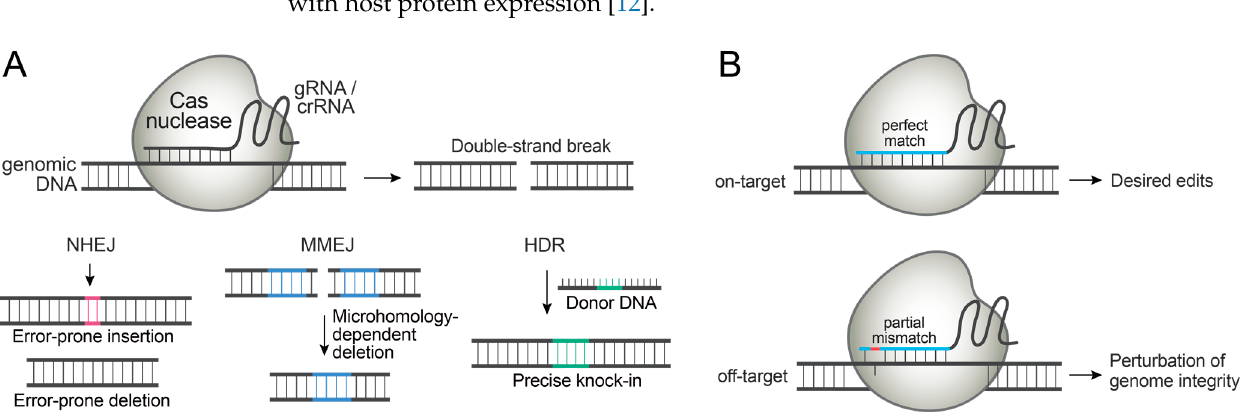
Figure 1. ( A ) Cas-nuclease-induced double-strand break (DSB) is repaired by endogenous cellular pathways. ( B ) Cas nucleases often tolerate partial mismatches and induce off-target DNA cleavages.